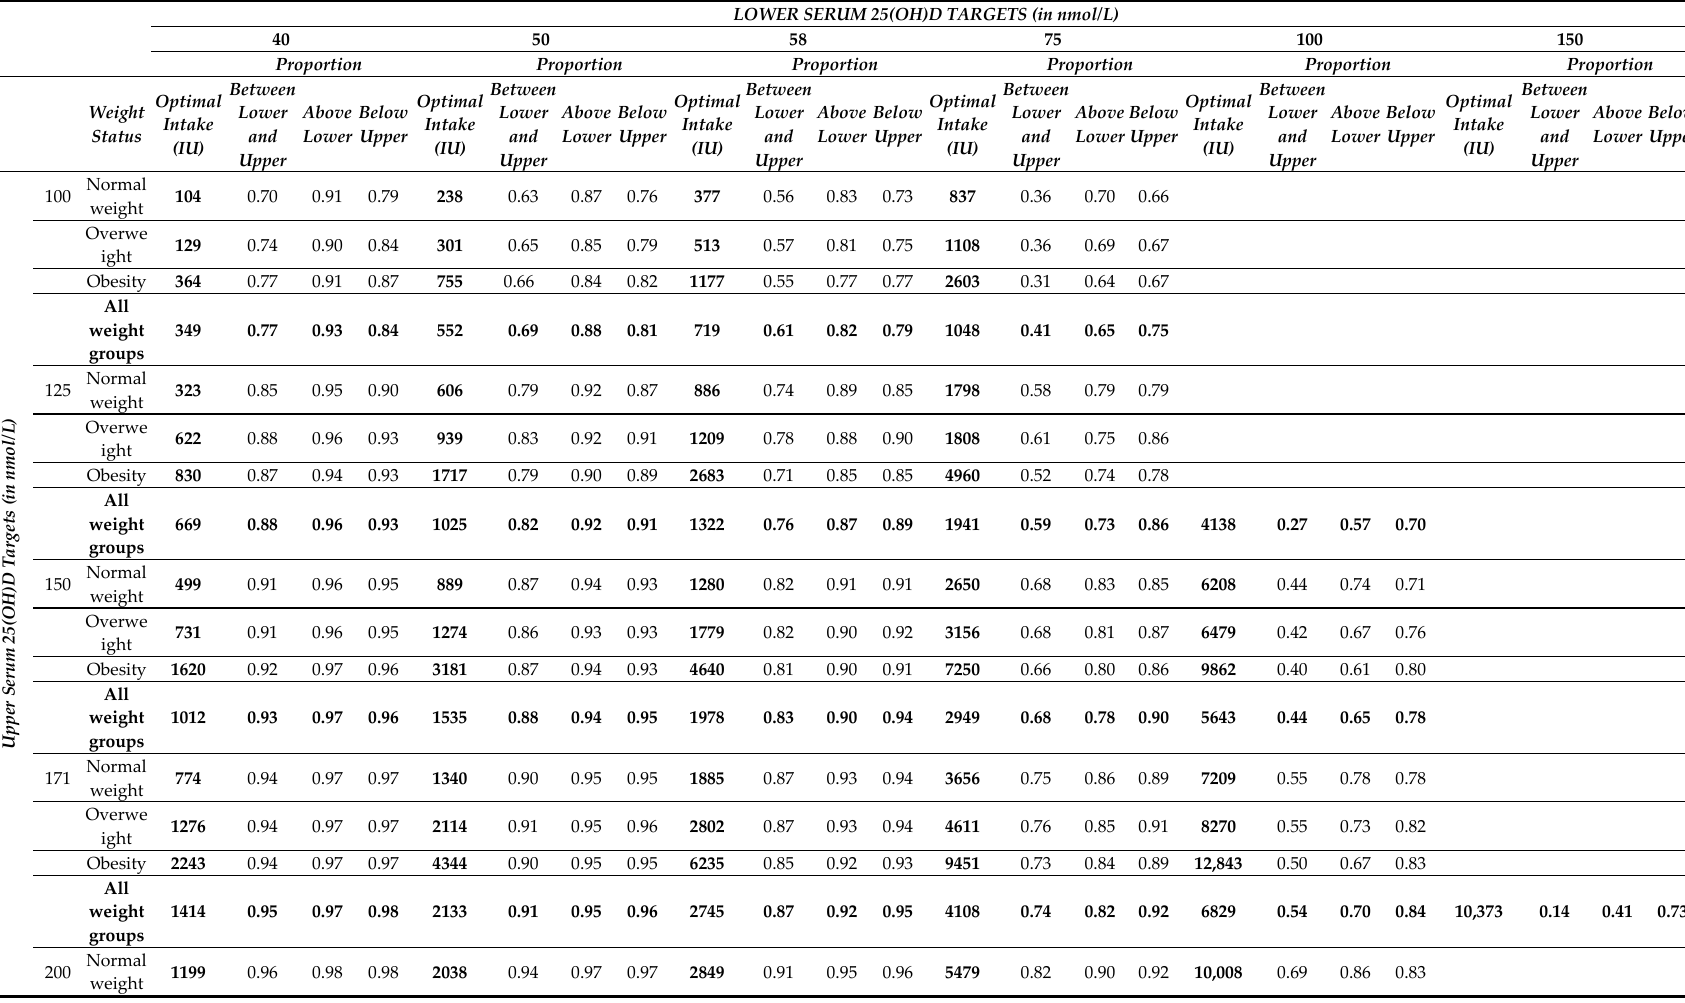
Table 2. Vitamin D supplementation that maximizes the proportion of participants with serum 25(OH)D concentrations within various lower and upper serum 25(OH)D